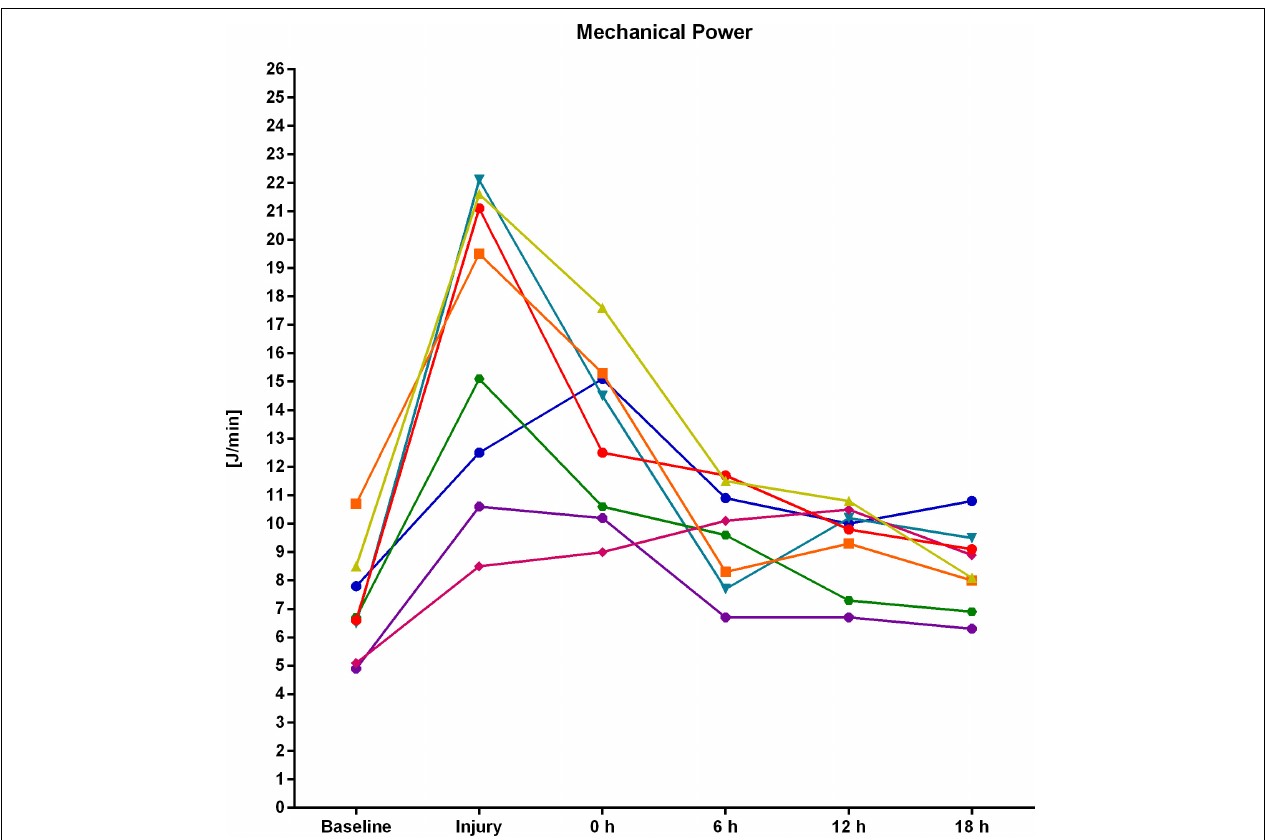
FIGURE 3 | Individual time course of mechanical power derived from the pressure–volume curve for each of the eight